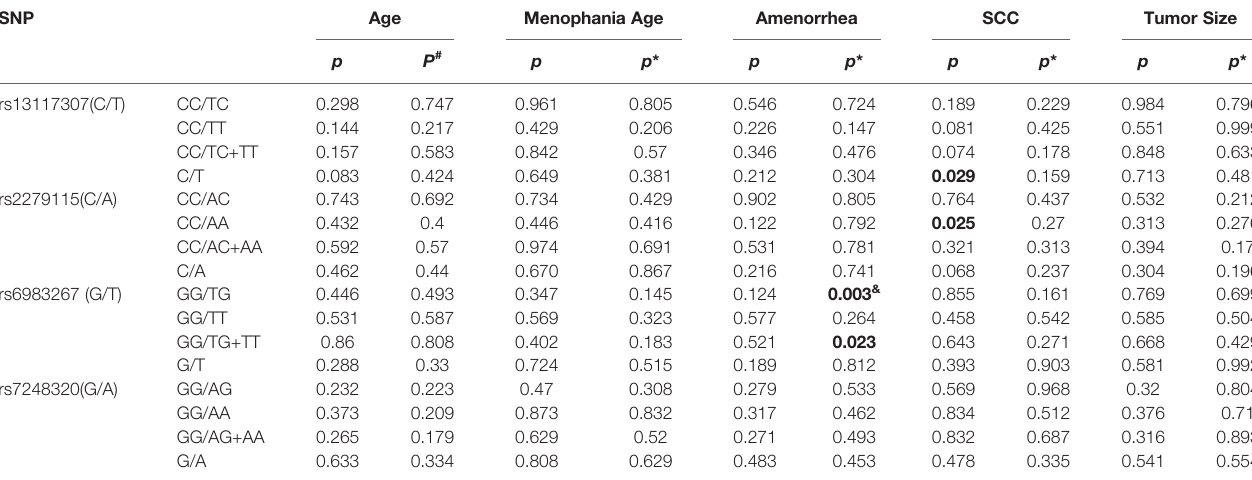
TABLE 4 | Genetypic association between four SNPs (rs13117307, rs2279115, rs6983267 and rs7248320) and CC-related risk factors. SNP